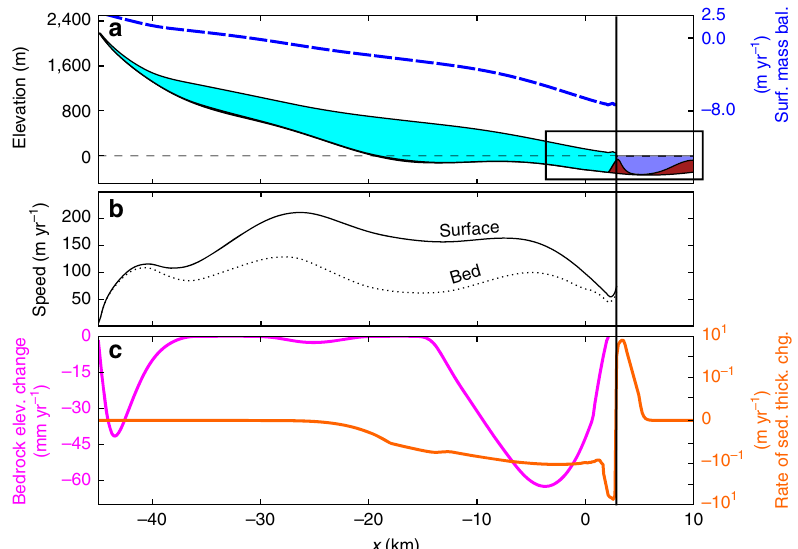
Fig. 2 Model state during the advance phase of the TGC. a Geometric state of the glacier and surface mass balance rate ( blue hashed line ) typical of glaciers in coastal Alaska. Black box corresponds to extent shown in Fig. 3. b Surface and basal velocities. c . Sediment thickness rate of change due to fl uvial transport ( orange ) and bedrock elevation rate of change due to basal sliding ( magenta line ), both of which were calibrated to roughly match observations from Taku Glacier in Southeast Taku Glacier ’ s terminus. The conclusions presented here are robust to parameter choices (Supplementary Note 1).